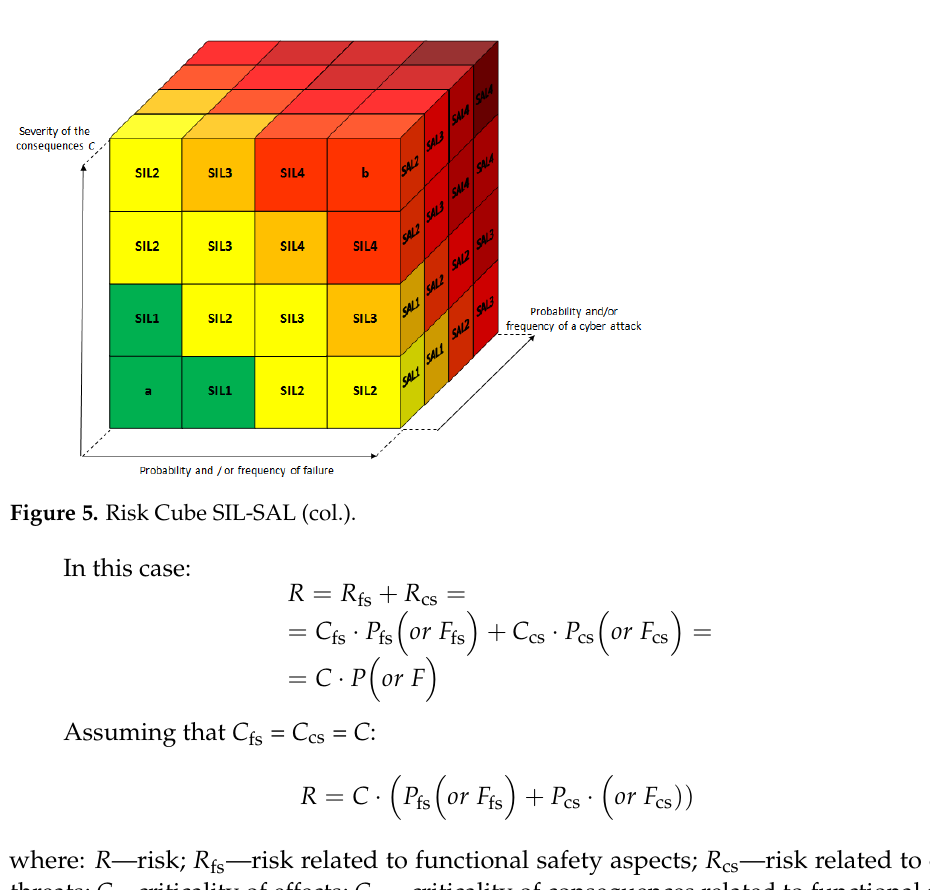
Figure 6. Risk Cube (SIL-EAL). In this case: